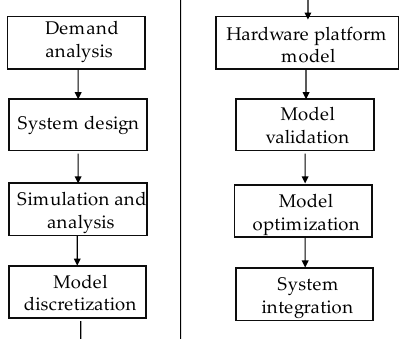
Figure 3. The general process of model-based design.